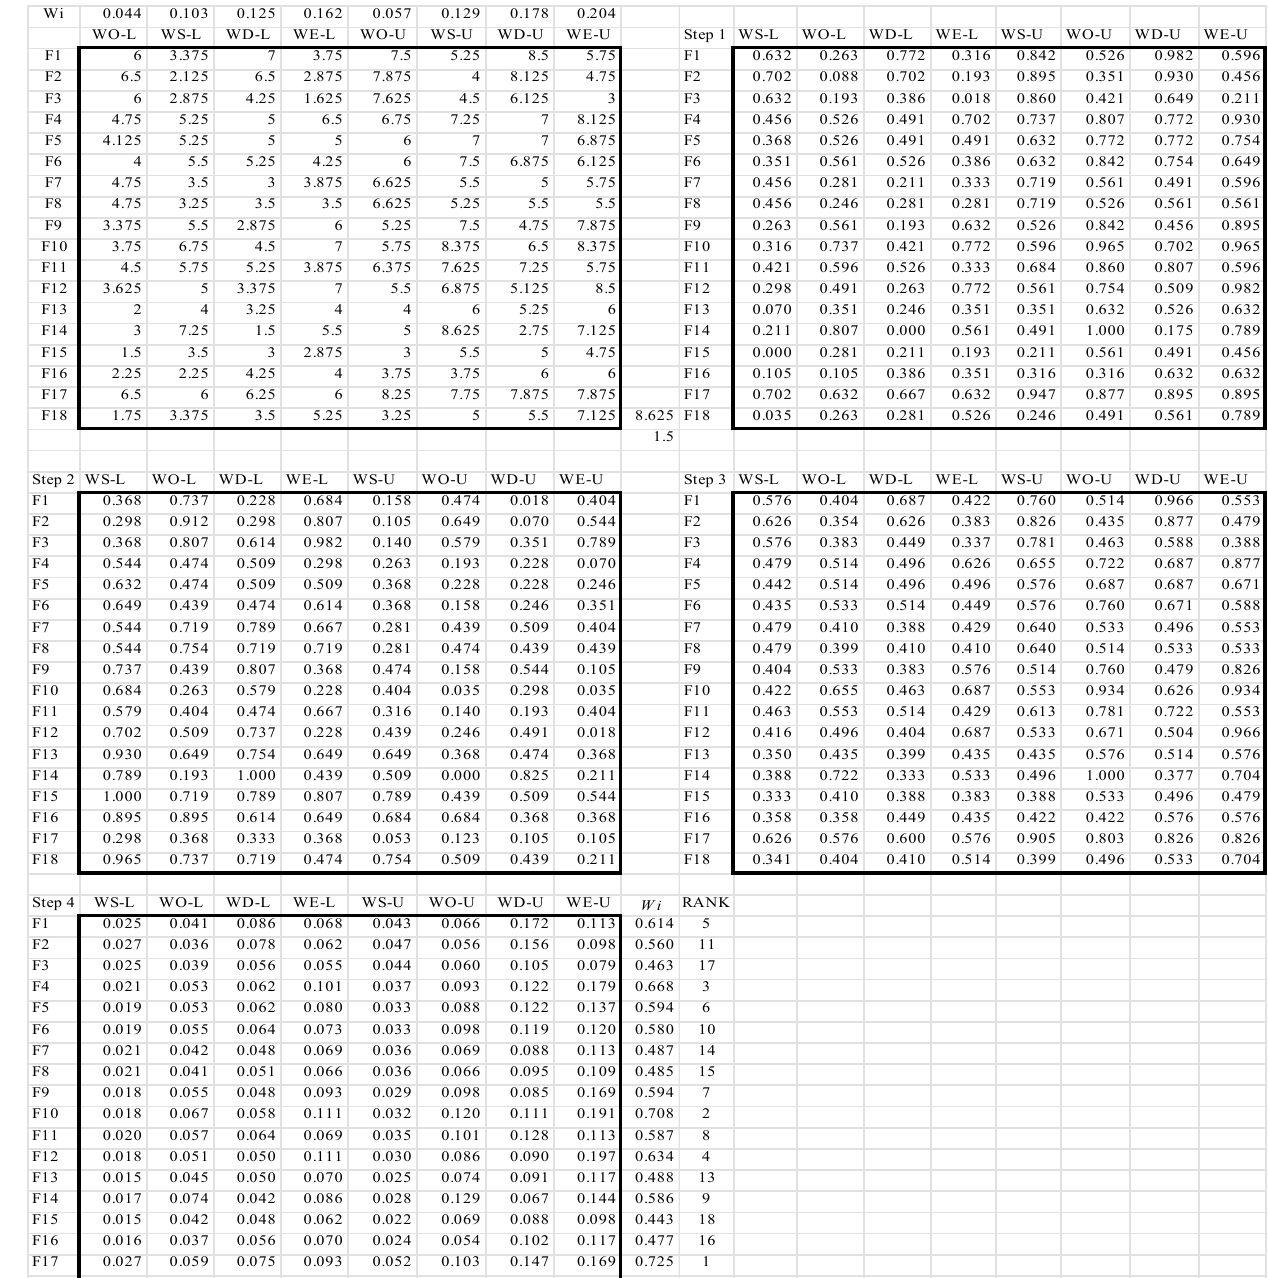
Figure A2. The GRA calculation steps for ranking 18 failure modes by EXCEL.